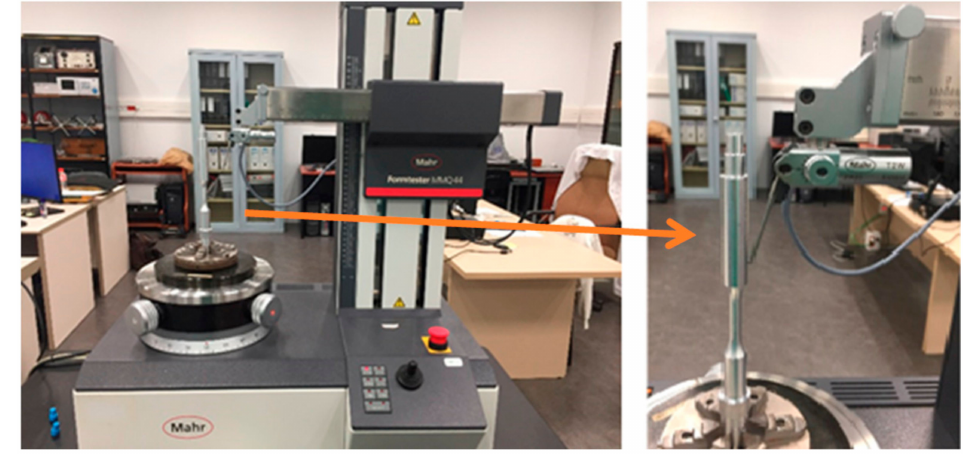
Figure 4. Form measuring system.